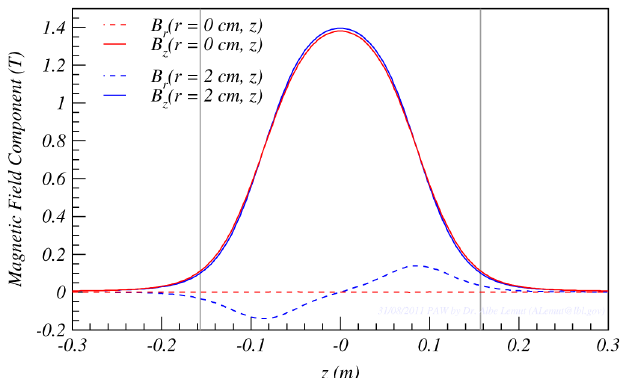
FIG. 6. Radial B r (dashed lines) and axial B z (solid lines) magnetic field components of the solenoid lenses calculated by OPERA-3D/TOSCA [21] for the center-line beam trajectory ( r ¼ 0 cm , red) and at radius r ¼ 2 cm (blue). The vertical grey lines represent the yoke face to face extension of the lens.